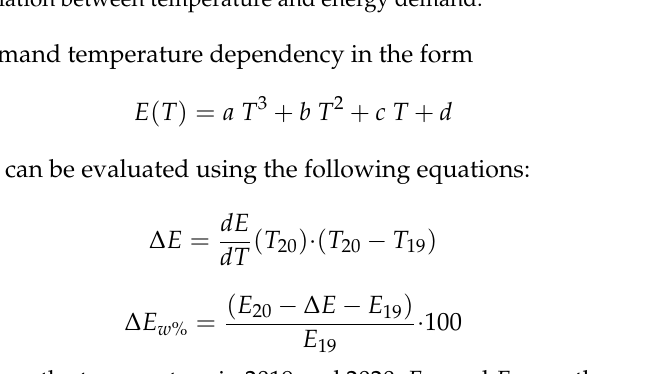
Figure 1. Typical correlation between temperature and energy demand.